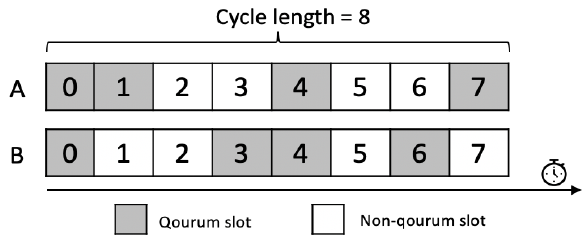
Figure 1. Example of intersecting quorums.